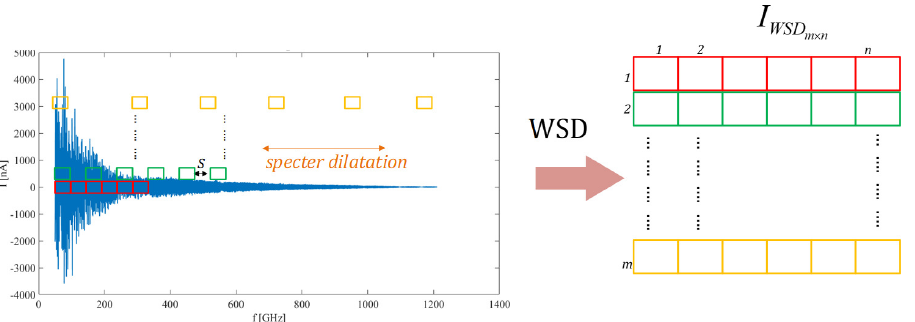
Figure 6. WSD transforms series into a two-dimensional image.